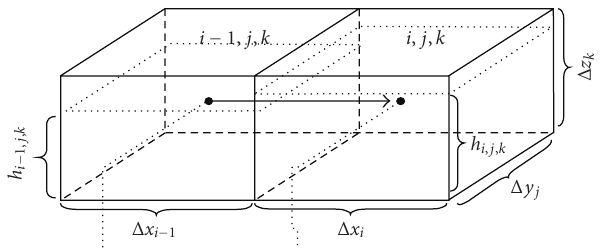
Figure 2: Groundwater flow for type (b)